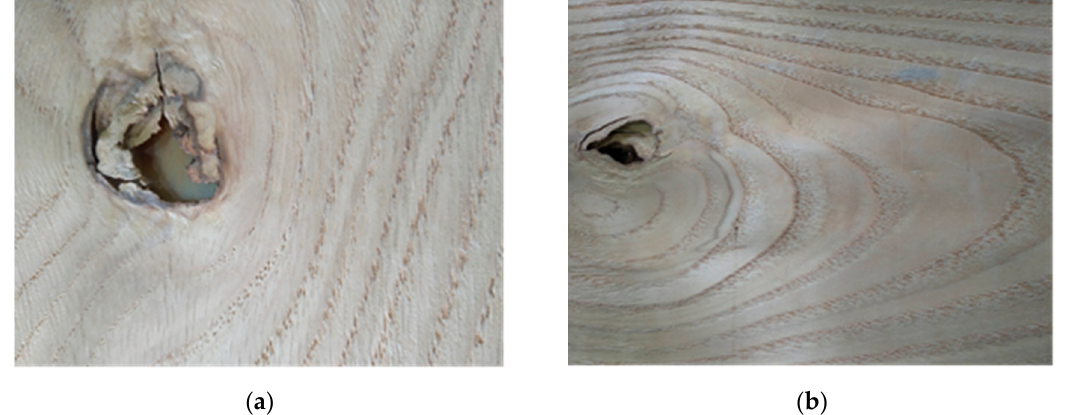
Figure 1. Dead knots in oak wood sliced plain-cut veneer ( a ), and in chestnut wood sliced veneer ( b ).